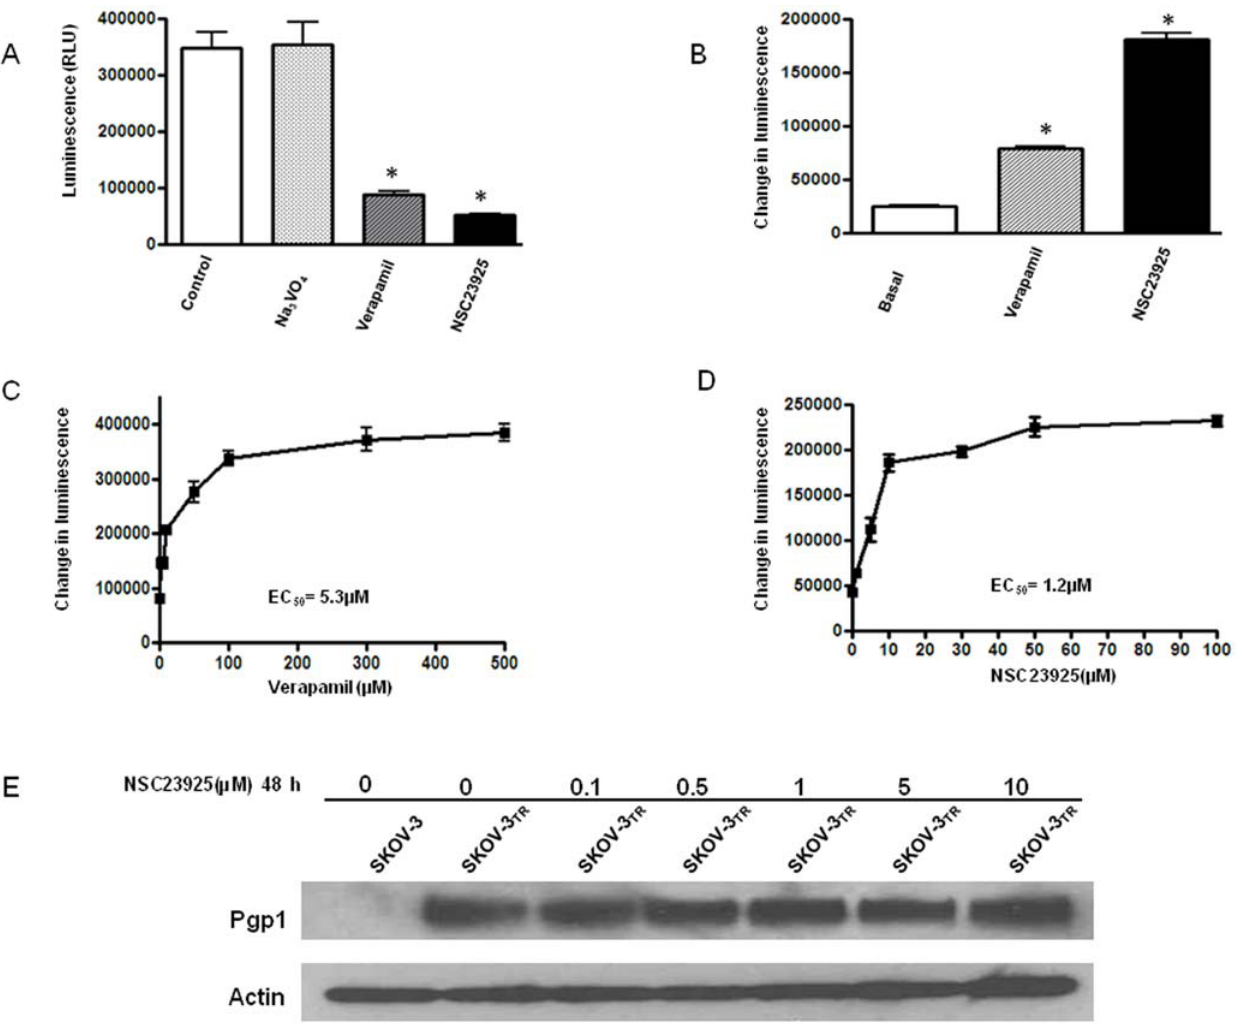
Figure 9. Stimulation of Pgp1 ATPase activity by NSC23925 as compared with verapamil. Untreated, 100 m M Na 3 VO 4 , 100 m M verapamil and 10 m M NSC23925 -treated Pgp1 reactions were performed according to the manufacturer’s protocol. Luminescence was read on a BMG LABTECH Polarstar Optima Luminometer. The decrease in luminescence of untreated samples compared to samples plus Na 3 VO 4 (ARLU basal ) represents basal Pgp1 ATPase activity. The decrease in luminescence of verapamil or NSC23925 treated samples represent Pgp1 ATPase activity. A : Decrease in luminescence of NSC23925 treated sample as compared with Na 3 VO 4 or Verapamil treated sample. B : Replotted the stimulation of Pgp1 ATPase activity by verapamil and NSC23925. C and D : Dose dependence of verapamil ( C ) and NSC23925 ( D ) stimulation of Pgp1 ATPase activity. The data were representative of one of three independent experiments. *, P , 0.001. E : Effect of NSC23925 on expression of Pgp1 in paclitaxel resistant cells. The paclitaxel resistant cell line SKOV-3 TR were treated with different concentration of NSC23925 for 48 h. Equal amounts (20 m g protein) of total cell lysates were used for each sample. Pgp1 expression was determined by Western blot as described in the Materials and Methods.